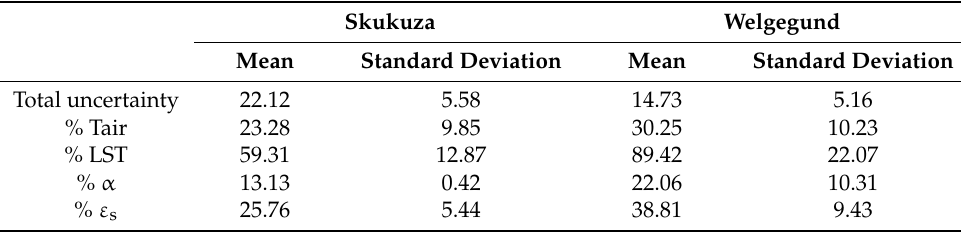
Table 4. Contribution of each input variable uncertainty to the total net radiation ( Rnet ) uncertainty.